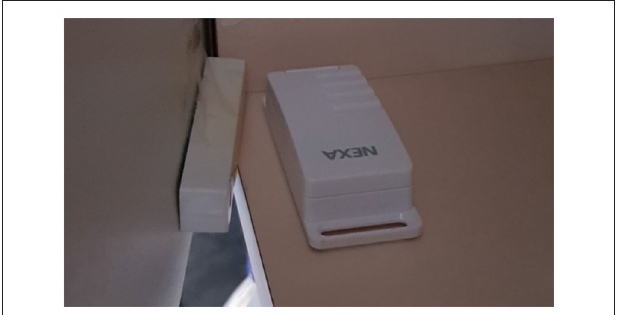
FIGURE 4 | Contact sensors attached to the door and frame of a kitchen cupboard.